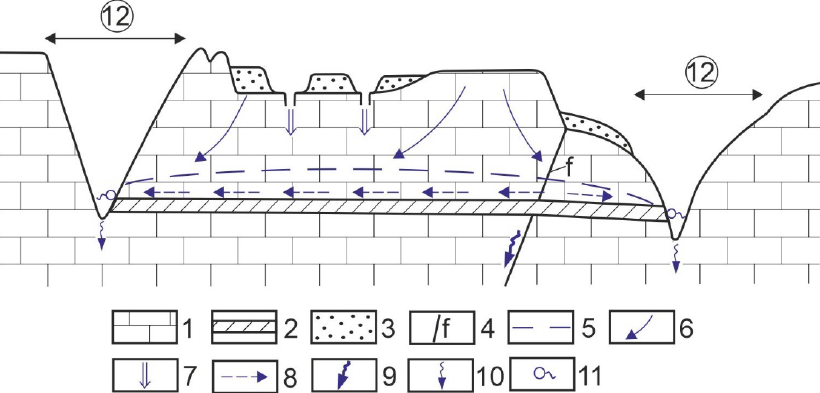
Figure 5. Water flow system of Mester-Hajag: Legend: 1. limestone, 2. impermeable intercalation, 3. permeable cover, 4. fault, 5. karstwater level, 6. infiltration, 7. local water inflow, 8. water motion above aquifuge, 9. water drainage along fault, 10. linear seepage, 11. spring, 12. epigenetic valley. As has already been mentioned, the mountains are separated into horsts of different elevations, expansions and evolutions [21]. The distribution of horst types in the mountains is described in Figure 6.